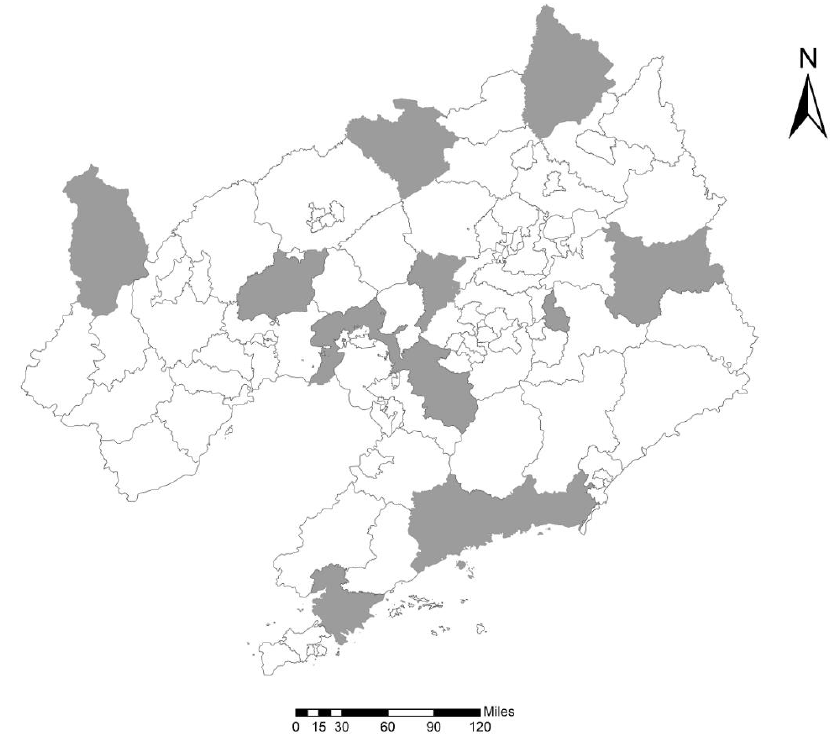
Figure 1. Map of sample distribution in the study areas. Note: This is a schematic map and does not indicate the definite boundaries.